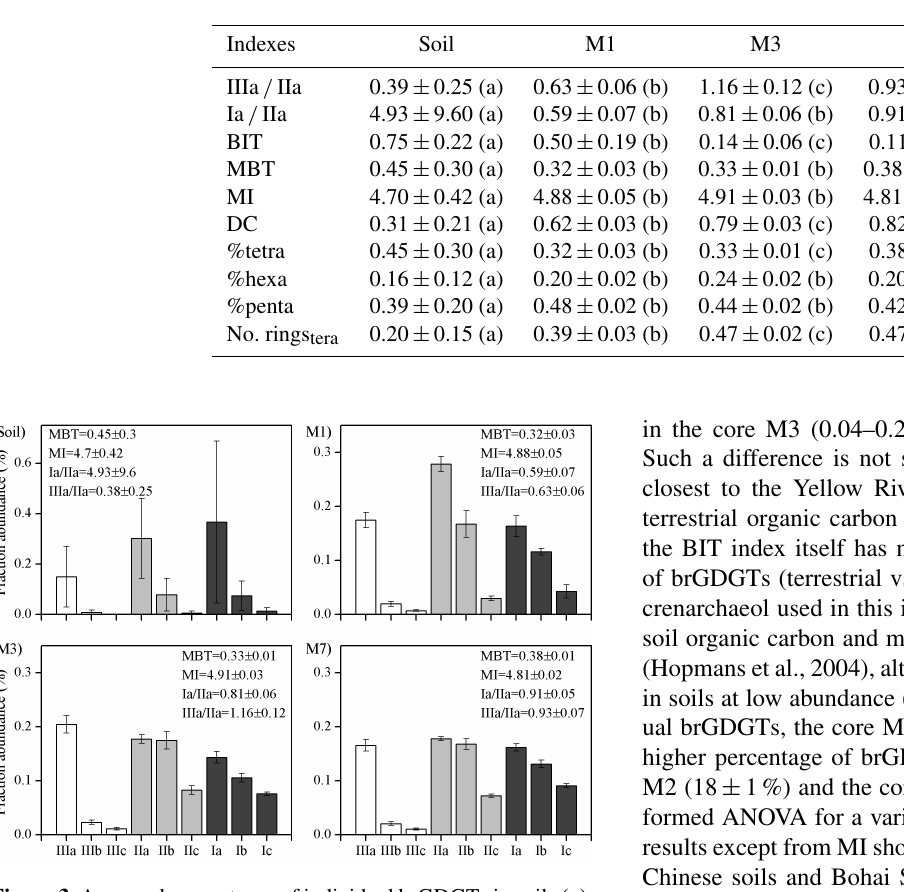
Table 1. Parameters including brGDGTs IIIa / IIa, Ia / IIa, the BIT index, MBT, MI, DC, percentages of tetra-, penta- and hexa-methylated brGDGTs and the weighted average number of cyclopentane moieties (no. rings for tetramethylated brGDGTs) based on the GDGTs from three cores (M1, M3 and M7; see Fig. 2) in the Bohai Sea. Different letters in parentheses (a, b, c, d) represent significant difference at the level of p <0.05.